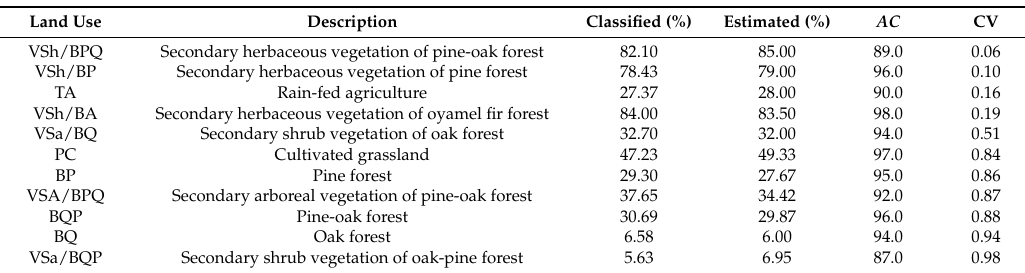
Table 3. Accuracy evaluation of the visual interpretation of the images in 12 sampling plots at nadir (understory